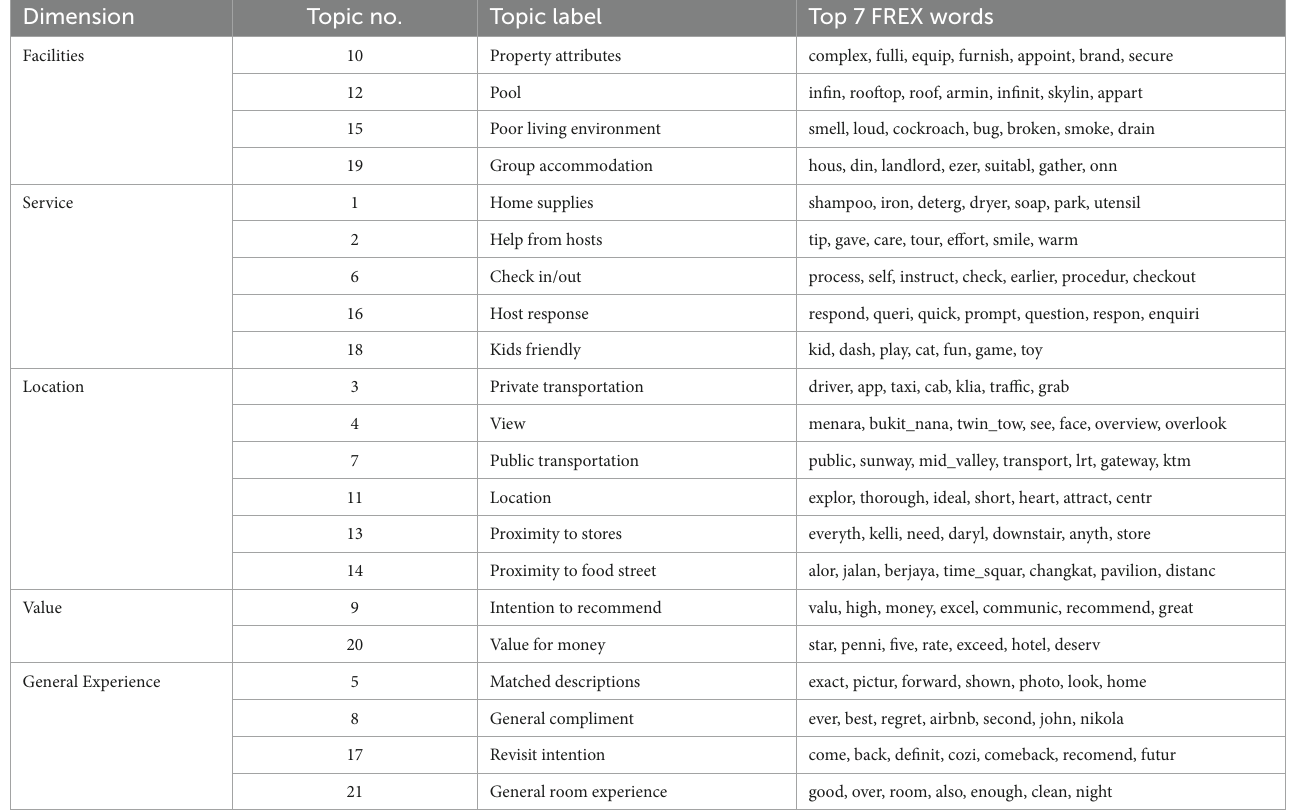
TABLE 1 Topic classification. Dimension Topic no. Topic label